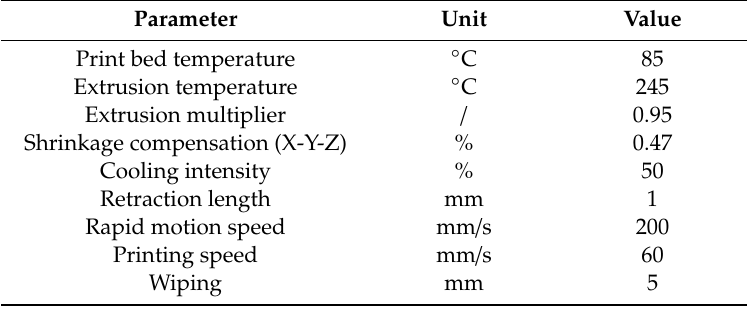
Table 7. Acrylester–Styrol–Acrylnitril (ASA) parameter table, nozzle: 0.4 mm